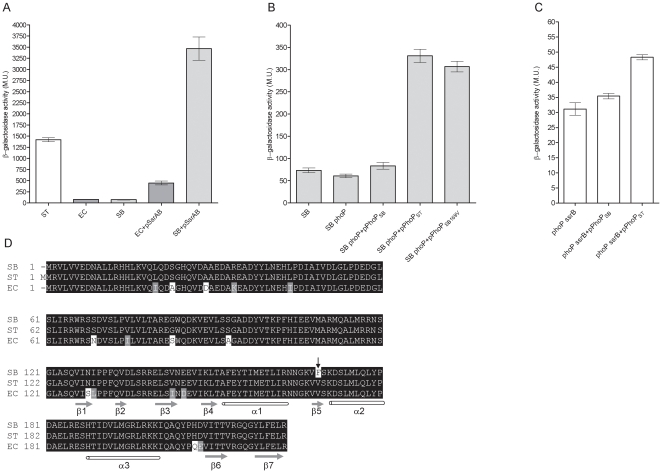
The PhoP regulator from S. enterica and a S. bongori SARC 12 strain are functionally different.(A) S. Typhimurium (ST), E. coli MC1061 (EC), S. bongori SARC 12 (SB) harboring sseL::lacZ in the presence or absence of SsrAB (pSsrAB) were tested for their β-galactosidase activities following growth in LPM medium. (B) S. bongori SARC 12 (SB), S. bongori phoP (SB phoP), and S. bongori phoP strain complemented with a S. bongori phoPQ (pPhoPSB), S. Typhimurium phoPQ (pPhoPST), or the S. bongori phoPQ harboring V169 (pPhoPSB169V) all carrying sseL::lacZ were tested for their β-galactosidase activity following growth under inducing conditions. (C) sseL::lacZ expression is shown in a S. Typhimurium phoP ssrB background without complementation (phoP ssrB), in the presence of the S. bongori PhoP (phoP ssrB+pPhoPSB) or in the presence of the S. Typhimurium PhoP (phoP ssrB+pPhoPST). (D) Amino acid alignment of PhoP sequences from S. bongori SARC 12 (SB), S. Typhimurium SL1344 (ST), and E. coli (EC; P23836) is shown. Identical, similar and disparate amino acids are shown in black, grey, and white, respectively. Secondary structural elements (α-helices in white and β-strands in grey) within the C-terminus domain were predicted using the SOPMA program and are correlated with the E. coli OmpRc structure. Amino acid variation between S. bongori and S. Typhimurium at position 169 is indicated by the black arrow.